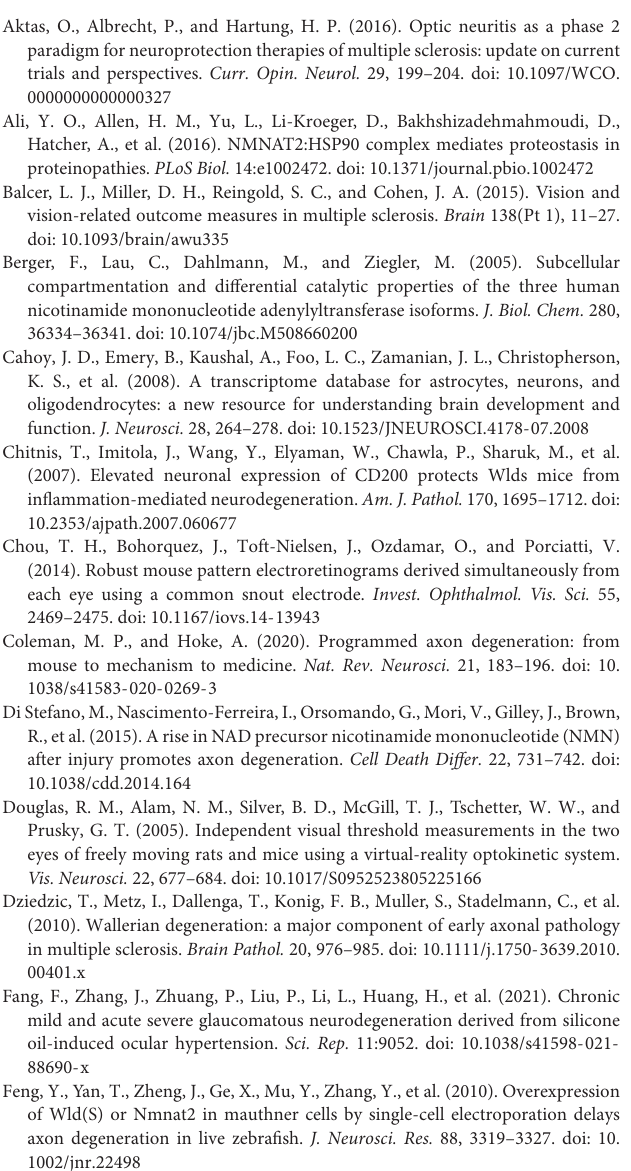
injected with control AAVs. (E) Upper panel: representative wholemount retina image with concentric circles drawn by ImageJ and the areas between the two green circles are eligible for peripheral retina RGC counting. Middle panel: peripheral flat-mounted retinas showing surviving RBPMS positive (green) RGCs 10 weeks after AAV2 intravitreal injection. Scale bar, 20 µ m. Lower panel: semi-thin transverse sections of ON with PPD staining. Scale bar, 5 µ m. (F) Quantification of surviving RGCs in wholemount retina and surviving axons in ONs 10 weeks after AAV2 intravitreal injection. n = 3. Data are presented as means ± SEM, ns: no significance, paired two-tailed t -test of NMNAT2-injected eyes and contralateral control eyes injected with control AAVs. Supplementary Figure 2 | There is no immune cell infiltration in retinas of EAE/optic neuritis mice. Confocal images of retina cross sections showing no inflammatory cell infiltration in EAE and sham mice at 3 wpi with or without NMNAT2 overexpression. Scale bar, 20 µ m. n =